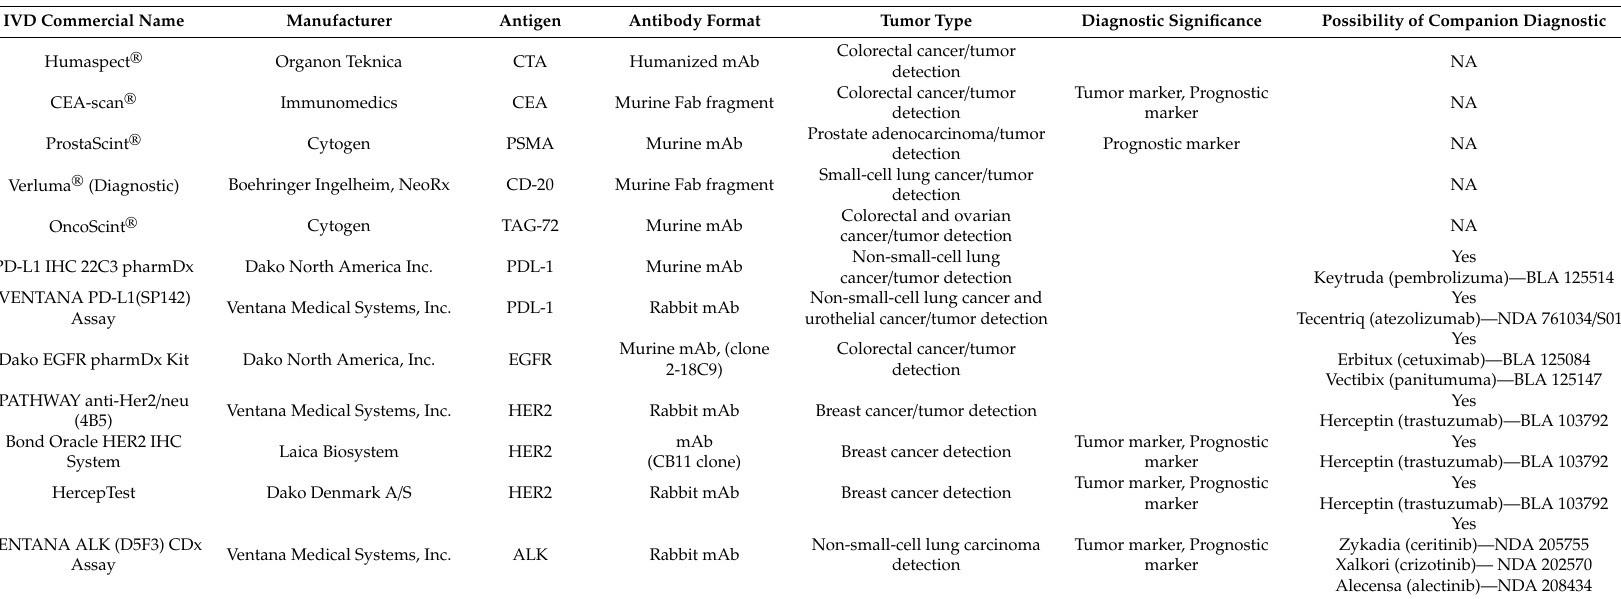
Table 1. Antibody-based in vitro diagnostics (IVDs) which are already approved by the FDA (Federal Drug Administration) and / or EMA (European Medicine Agency) and used for cancer diagnosis. CTA, Cancer-testis antigen; CEA, carcinoembryonic antigen; PSMA, prostate-specific membrane antigen; TAG-72, tumor-associated glycoprotein 72; PDL-1, programmed death-ligand 1; HER 2, human epidermal growth factor receptor 2; EGFR, epidermal growth factor receptor; ALK, anaplastic lymphoma